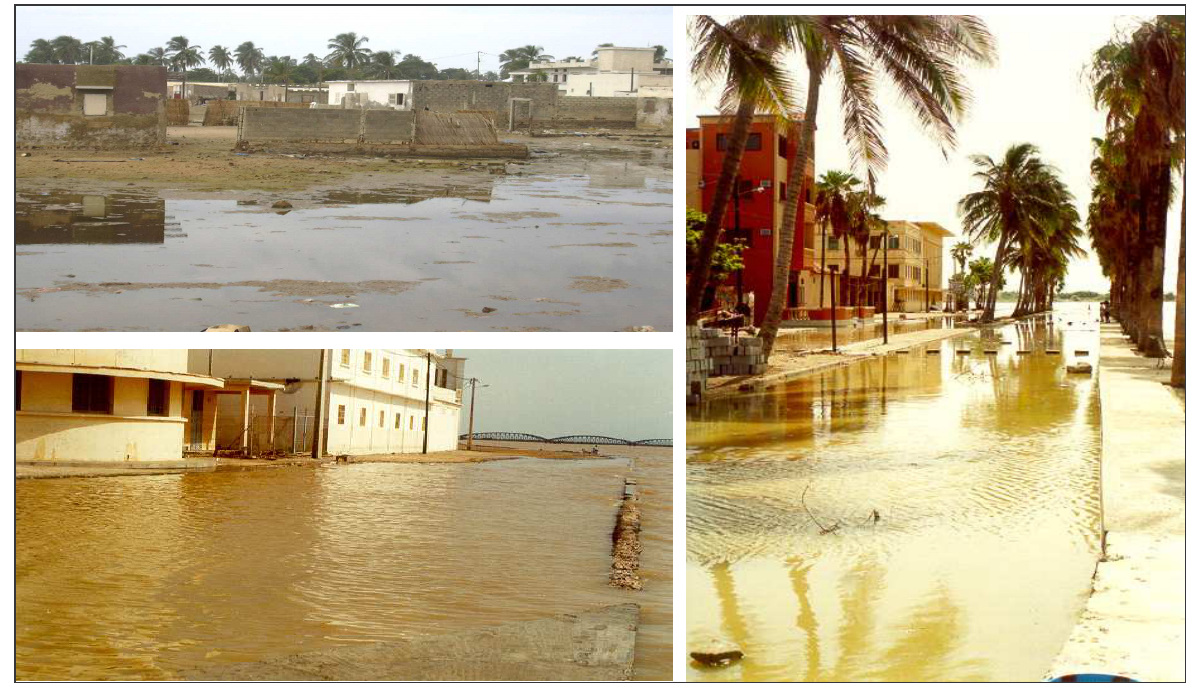
Figure 5: A view of flooded area in Saint-Louis in